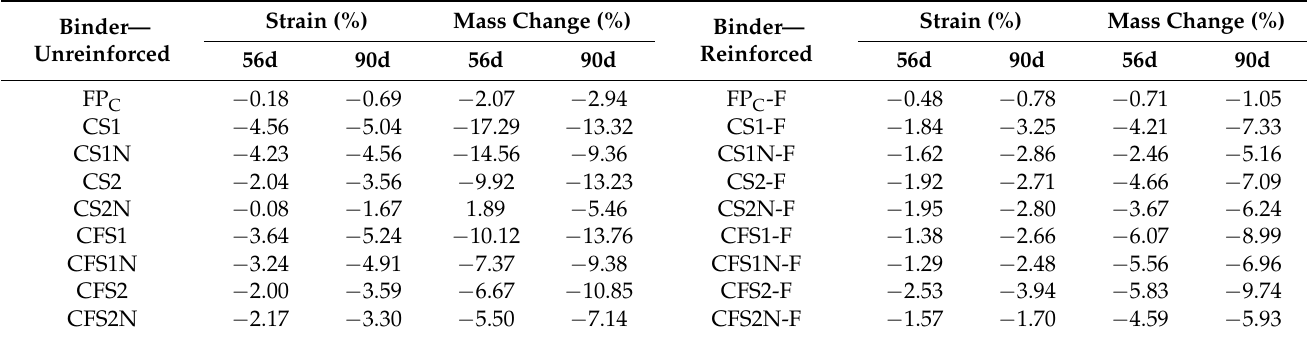
Table 4. Length and mass change of binders without and with fibers in ambient curing